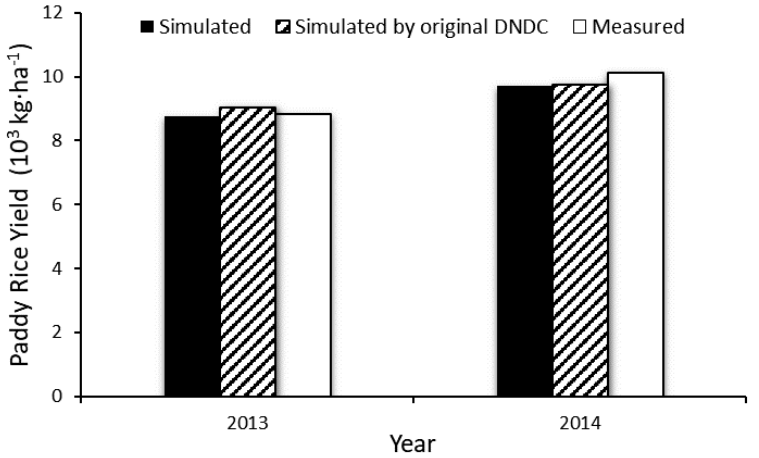
Figure 5. Comparison between simulated and measured values of crop yield [22].